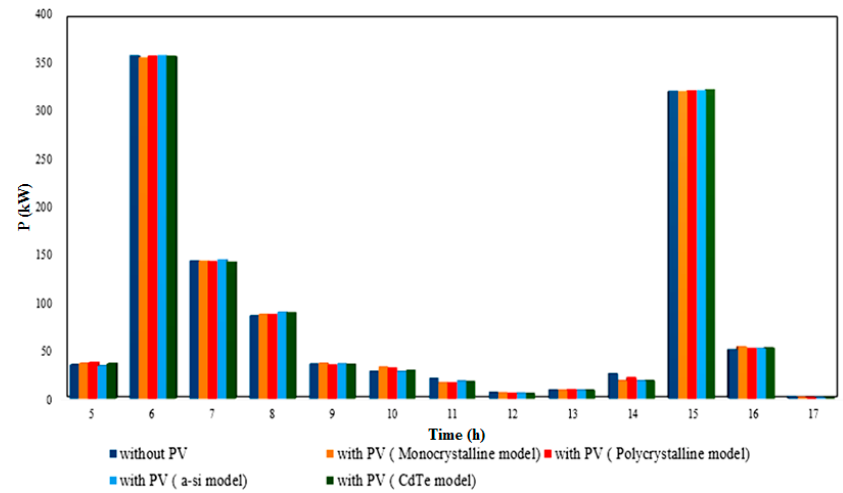
Figure 9. Discharging energy from PL to DSO in February.